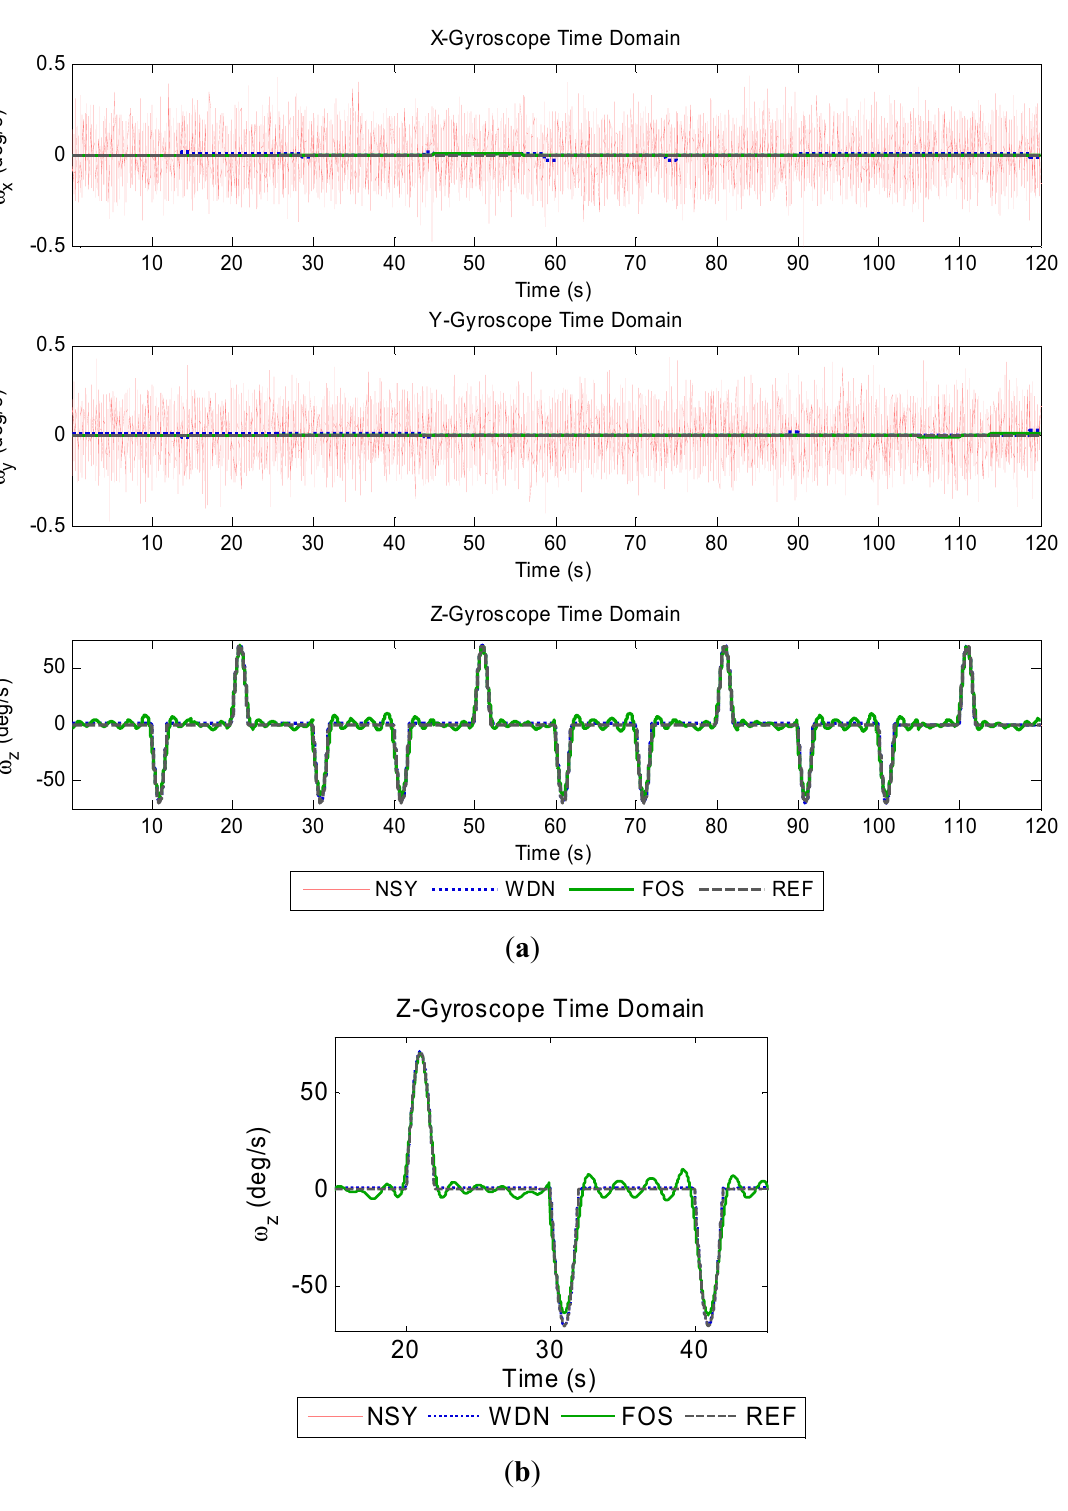
Figure 2. Accuracy enhanced gyroscope signals. ( a ) Gyroscope signals. ( b ) Zoomed-in section of z-gyro illustrating